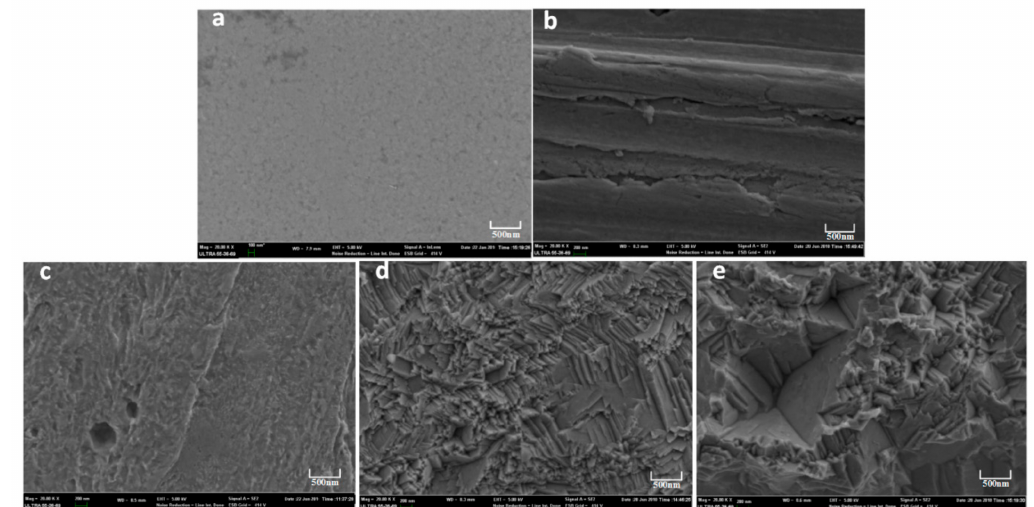
Figure 2. Surface morphology of Ni laminated films treated at different methods: ( a ) untreated; ( b ) treated with 5 vol % HCl with 10 min; ( c ) treated with anodic current of 10 mA with 10 min; ( d ) treated with anodic current of 20 mA with 10 min; ( e ) treated with anodic current of 20 mA with 10 min.